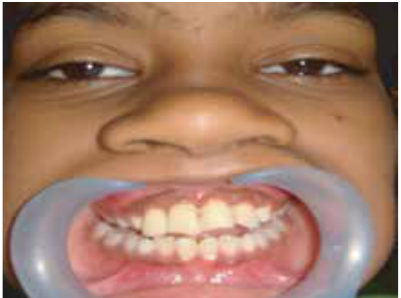
Fig 9. Periapical image after 12 months Fig 10. Photograph after 12